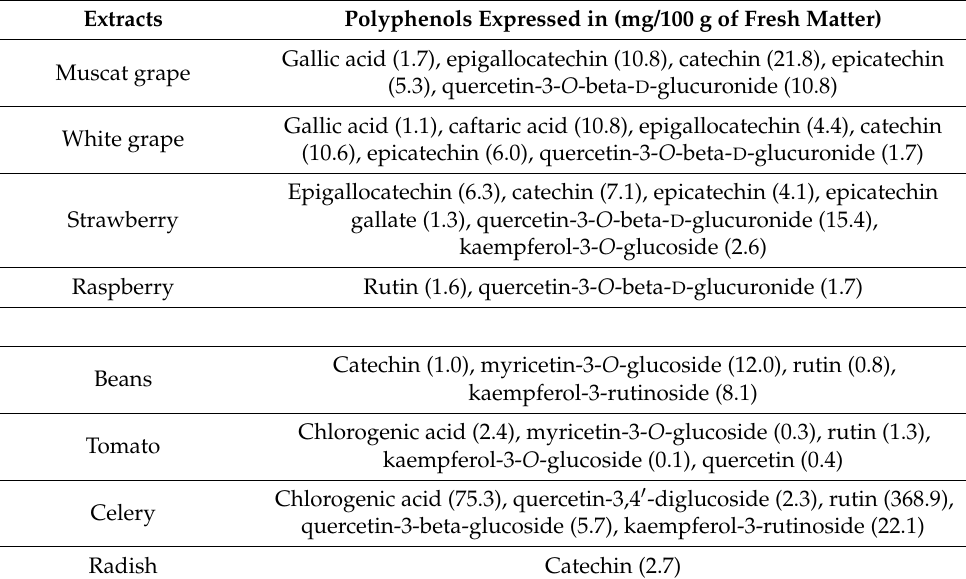
Table 2. Fruit and vegetables with high polyphenols content characterized by important anti-oxidant activity. Adapted from Debbabi et al.